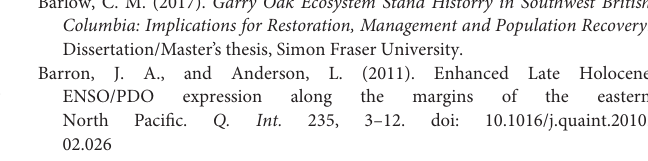
S1 Supporting Information for Regional Study Sites | Regional fire history study site comparison table. S2 Table | 210 Pb and AMS- 14 C age determinations on Somenos and Chadsey Lake cores. S3 Text | The effect of different chemicals on charcoal abundance and